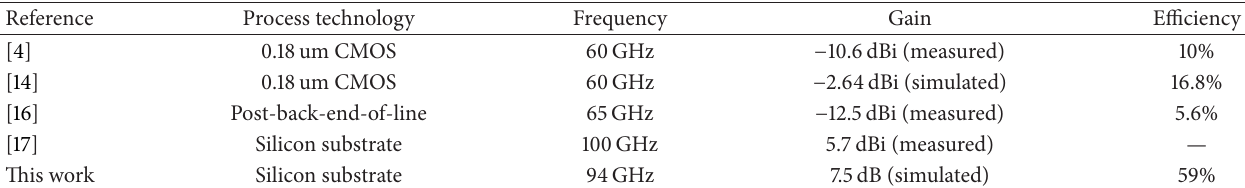
Table 3: Performance comparison with other related work in the